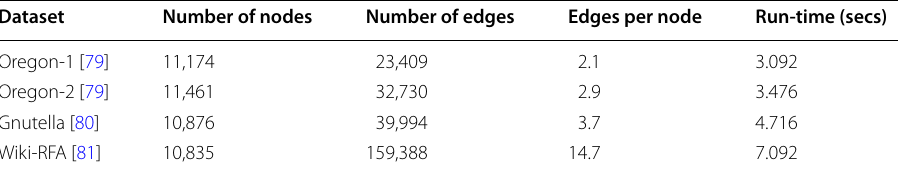
Table 6 Run-time by network complexity